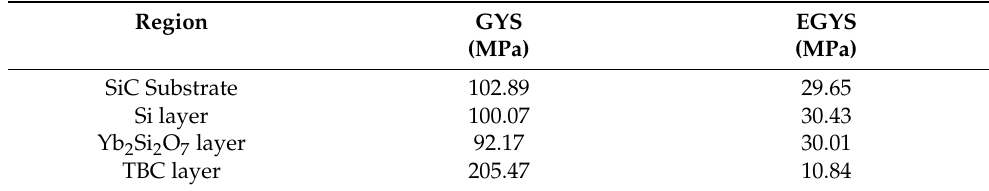
Table 2. S22_Max in each region of GYS and EGYS coating systems.